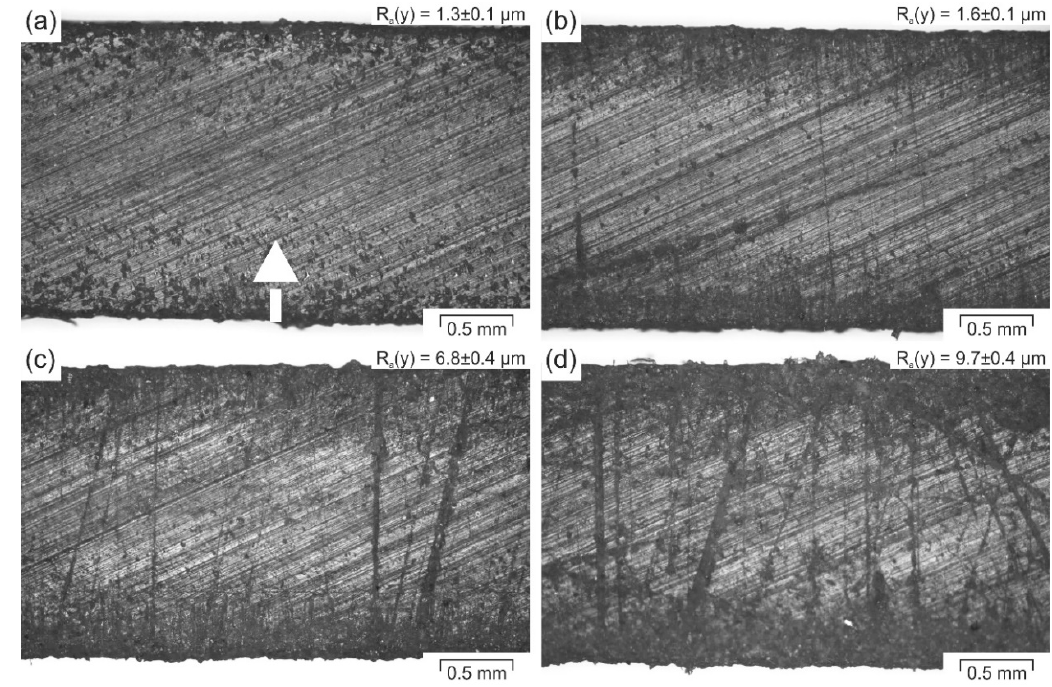
Figure 7. Optical microscopy images of a strand of the printed PP-compound after being sheared-off from differently modified UHMW-PE build platform surfaces: Unmodified ( a ); sanded by a scrub sponge ( b ); by sandpaper with an average particle diameter of 82 µ m ( c ); and by sandpaper with an average particle diameter of 190 µ m ( d ). In the top right corner of each image, the corresponding R a (y)-value of the build platform, onto which the strand was printed, is represented. The arrow displayed in ( a ) highlights the loading direction of the measuring device, which is the same for all four images.